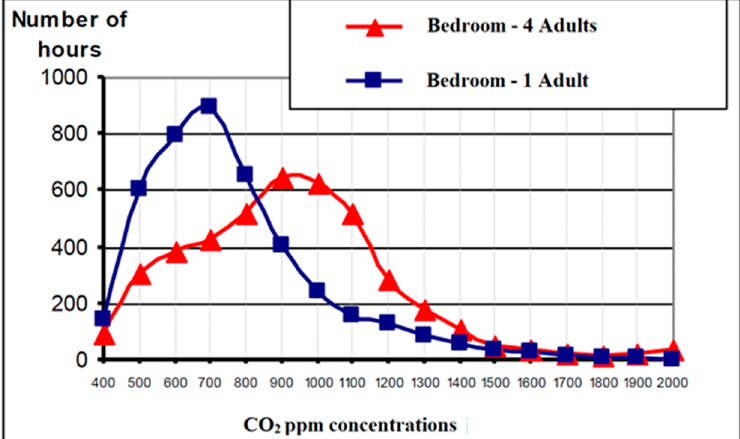
Figure 12. Hourly CO 2 concentration measurements in two different bedrooms with low occupancy (1 adult) and high occupancy (4 adults) periods annually [76].